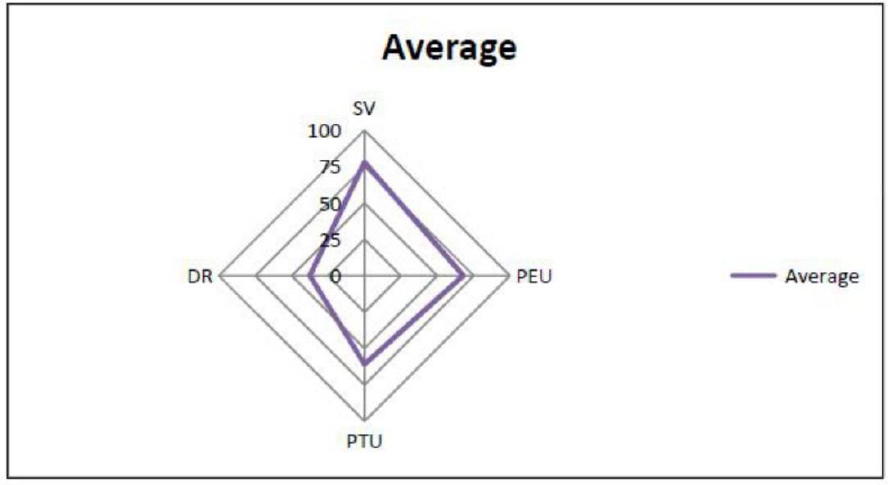
Figure 14. Polygon representation of the SV, PEU, PTU, and GR average values for the Cenozoic Malaguide Basin from Sierra Espuña.